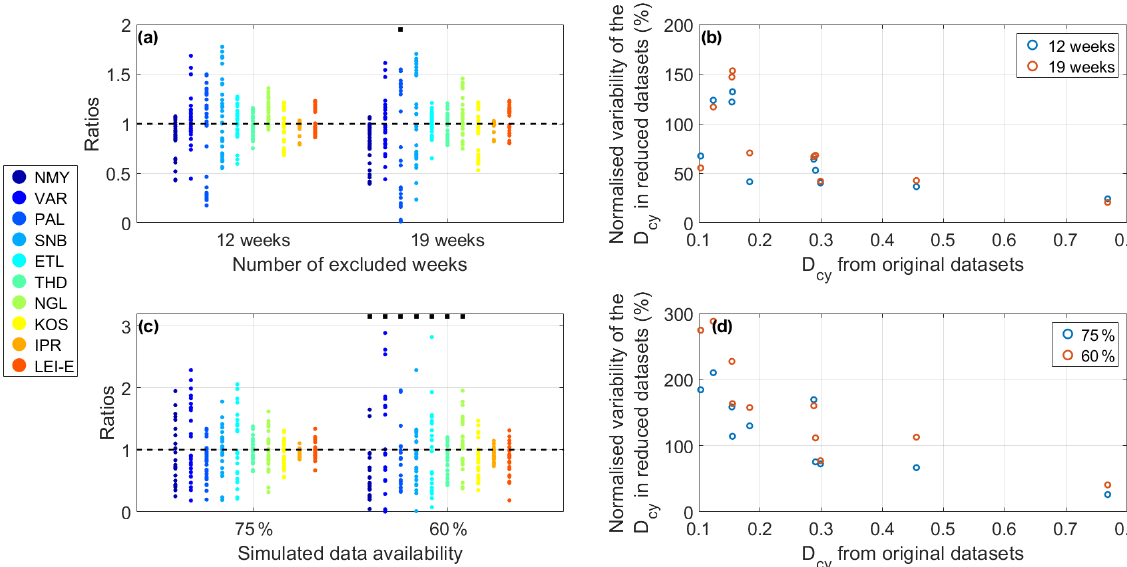
Figure 4. Variability of the diel cycle ( D cy ) of N tot in datasets with data availabilities degraded to ∼ 60% and ∼ 75% as a result of the exclusion of 12 and 19 consecutive weeks (all possible combinations tested) (two top panels) and individual hourly averages (test repeated 25 times) (bottom two panels). In (a) and (c) , the ratio between the newly derived D cy value and that calculated from the original dataset was calculated for each reduced dataset. Black squares indicate the occurrence of negative D cy values (not considered in the calculation of the ratios) at the corresponding sites. Panels (b) and (d) show the variability of D cy , calculated for each site and each target data availability as the difference between the maximum and the minimum of D cy derived from the reduced datasets normalized by D cy calculated from the complete time series, as a function of the original D cy